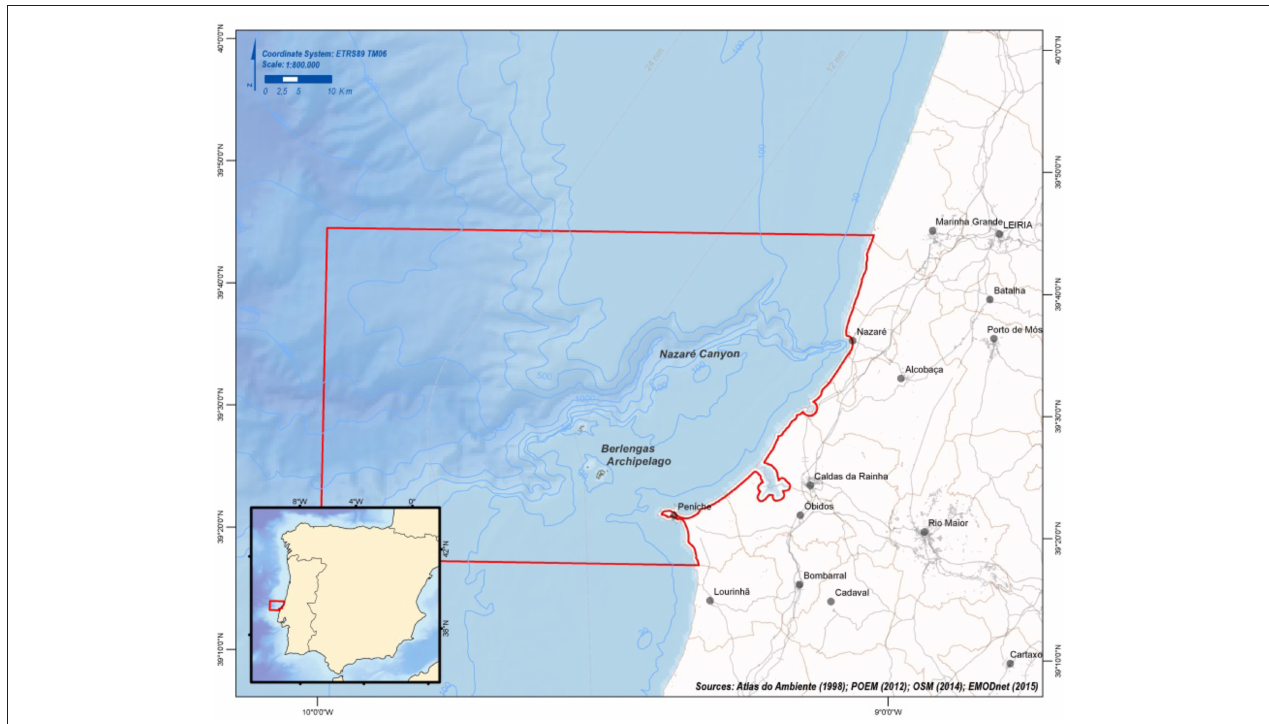
FIGURE 1 | The location of the complex Atlantic region between Peniche and